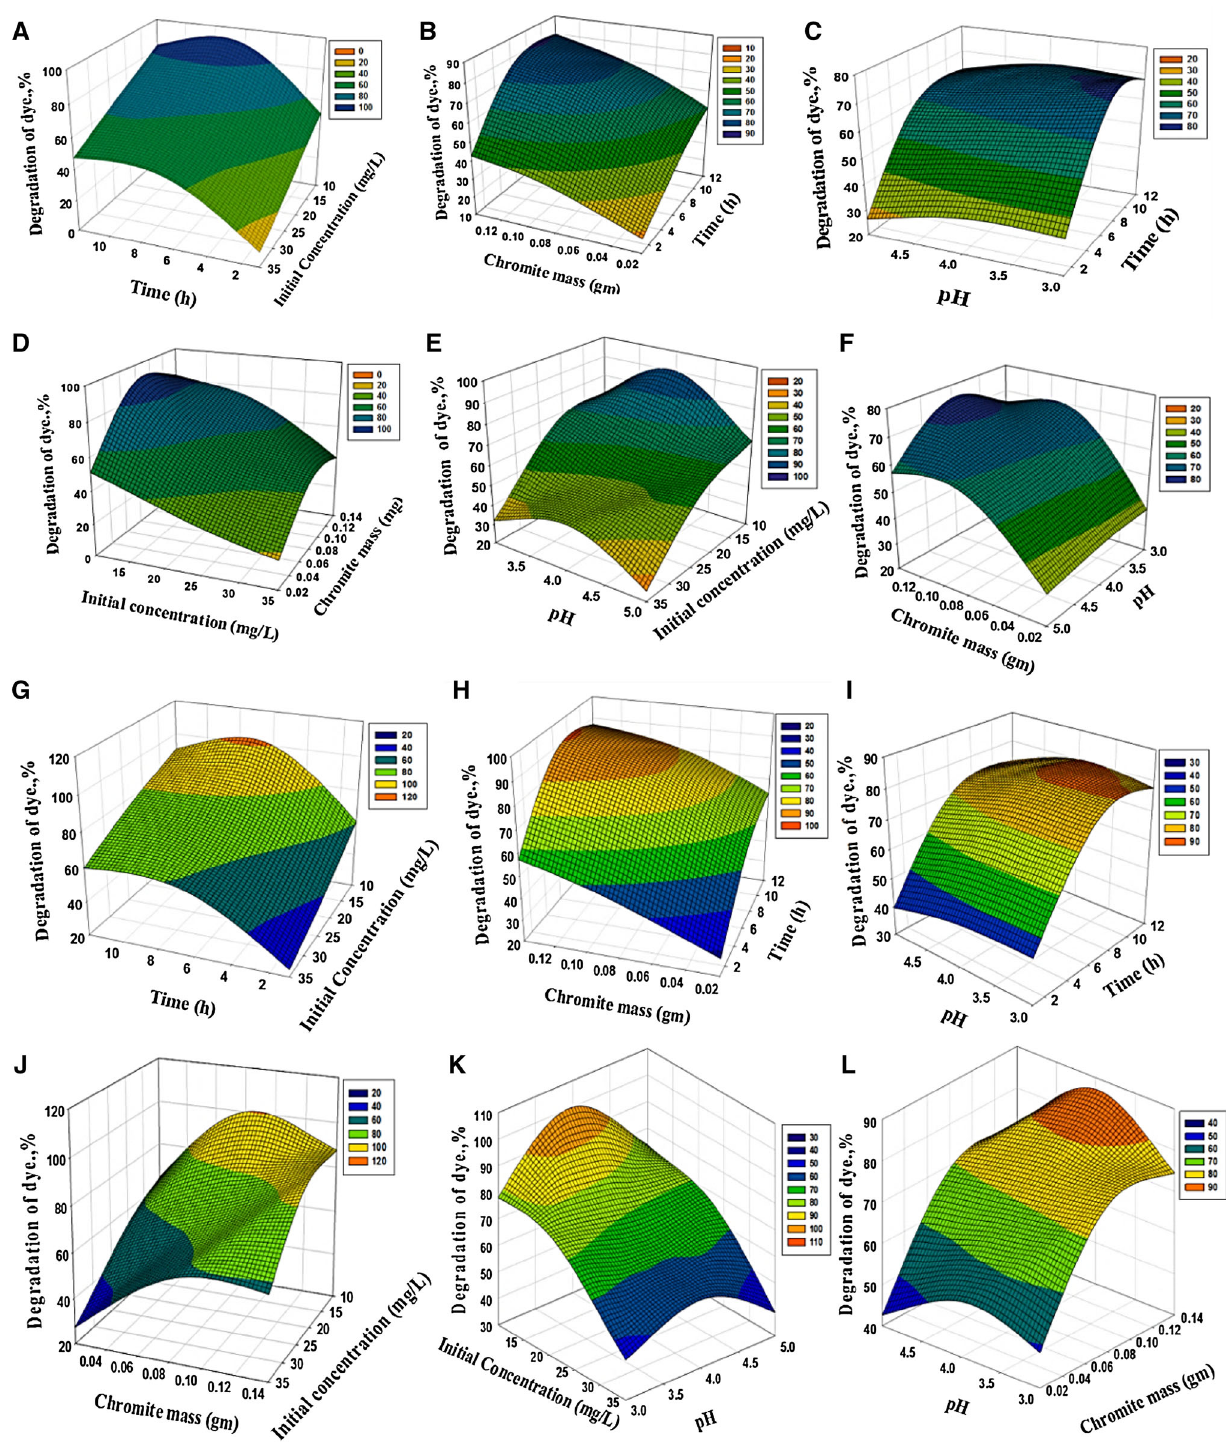
Fig. 9 3D response surface diagrams for the interaction between the operating parameters during photodegradation of Congo red dye by chromite (a – f ), and Fenton’s oxidation of Congo red dye by chromite ( g – l